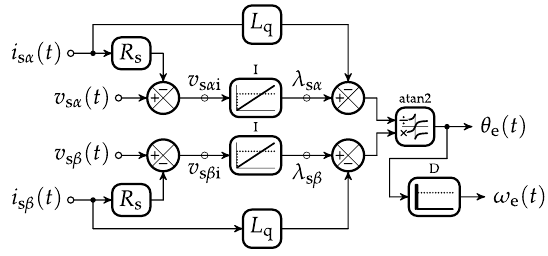
Figure 1. A block diagram of the proposed observer for the flux-based sensorless FOC of PMSMs based on the voltage model in the stator reference frame.